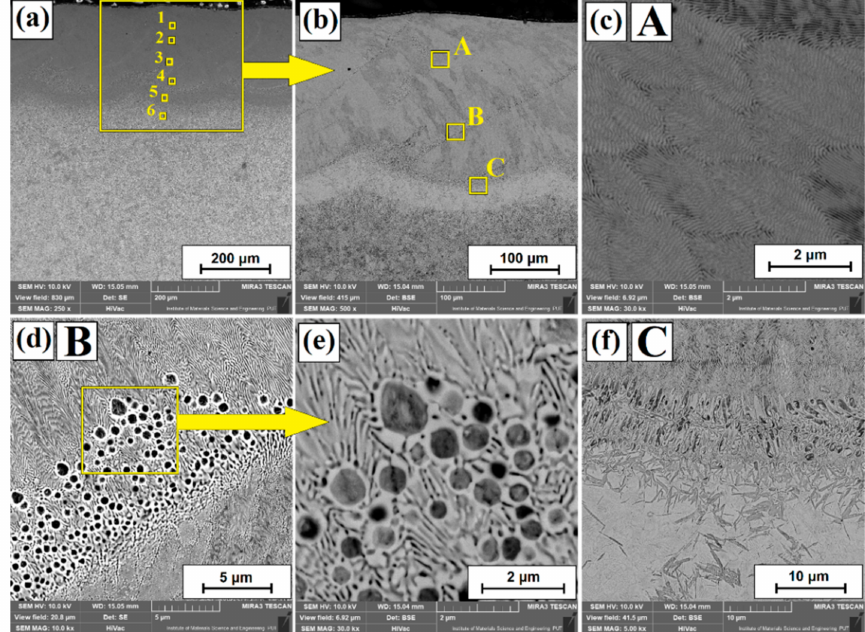
Figure 3. Microstructure of B-Cr coatings obtained using laser processing by laser beam power of 600 W: laser tracks ( a ), enlarging the laser track ( b ), upper area of remelted zone ( c ), middle area of remelted zone ( d ), enlarging of middle area of remelted zone ( e ), and boundary between the remelted zone and the heat-affected zone ( f